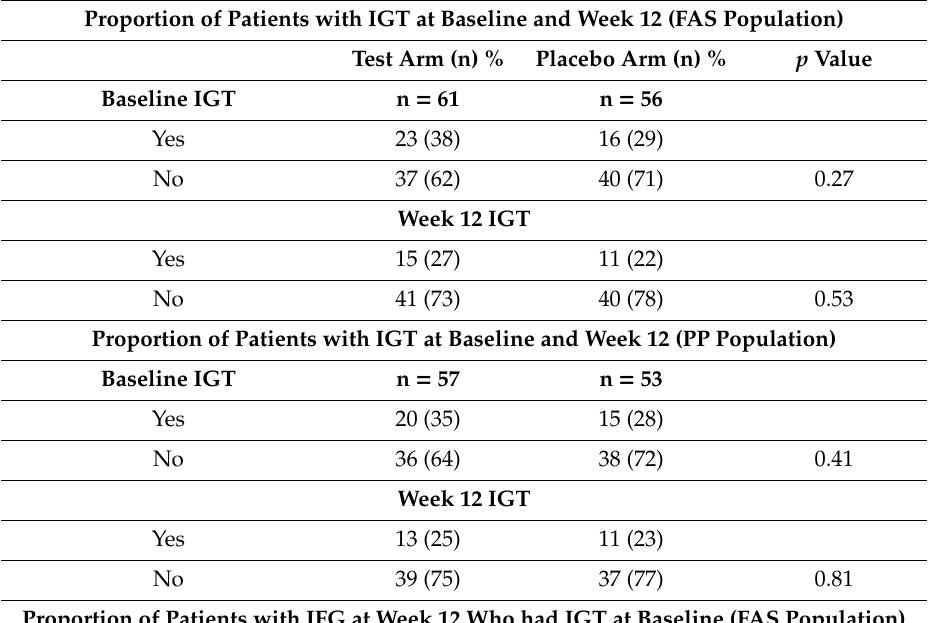
Figure 2. Subjects administered metformin with the investigational formulation or placebo. Table 3. Impaired glucose tolerance for the FAS population and PP